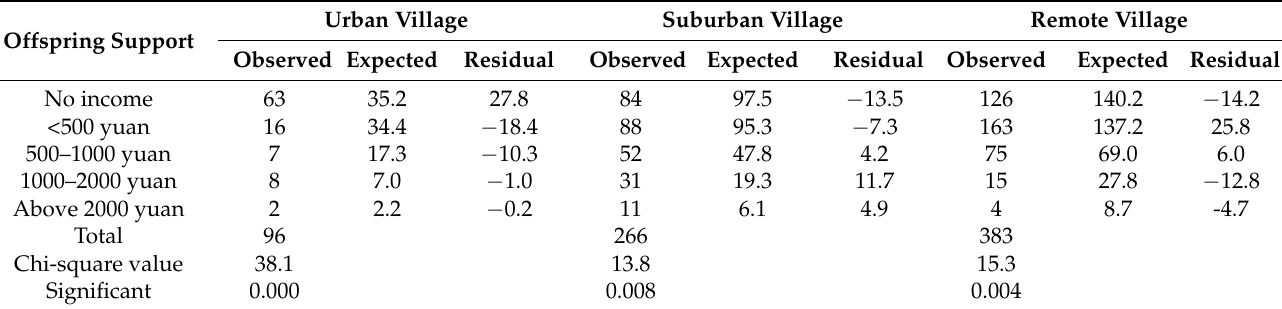
Table 2. Non-parametric chi-square test of offspring support in rural